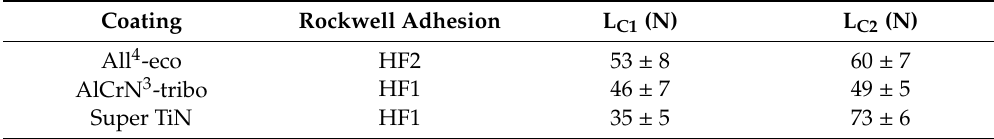
Table 2. Adhesion of the tested PVD coatings.